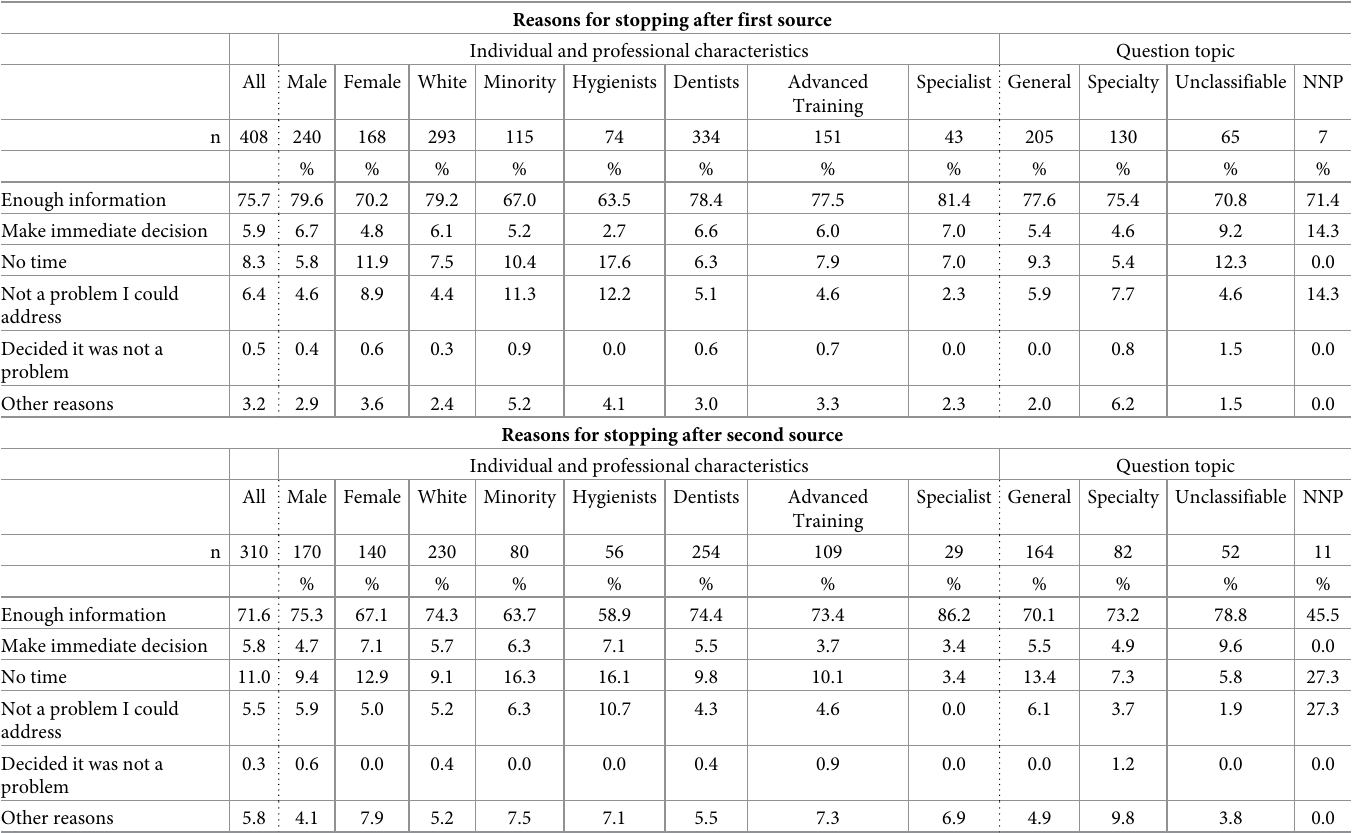
Table 5. Reasons for stopping search by sample